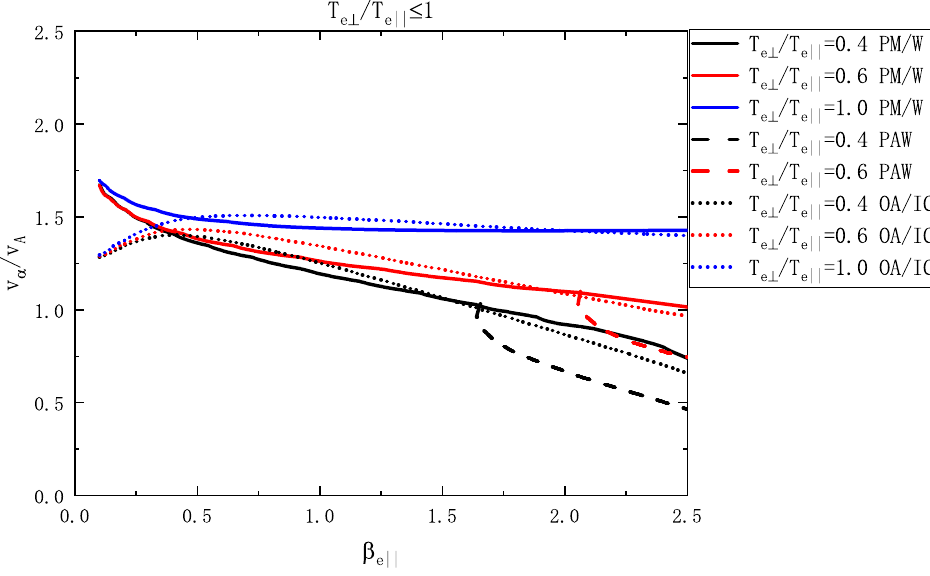
Figure 6. The instability threshold as a function of β e (cid:107) and v α / v A in the region of T e ⊥ / T e (cid:107) ≤ 1, where the solid, dashed, and dotted lines represent the PM/W, PAW, and OA/IC instabilities, respectively, and the black, red, and blue lines correspond to T e ⊥ / T e (cid:107) = 0.4, 0.6, and 1,